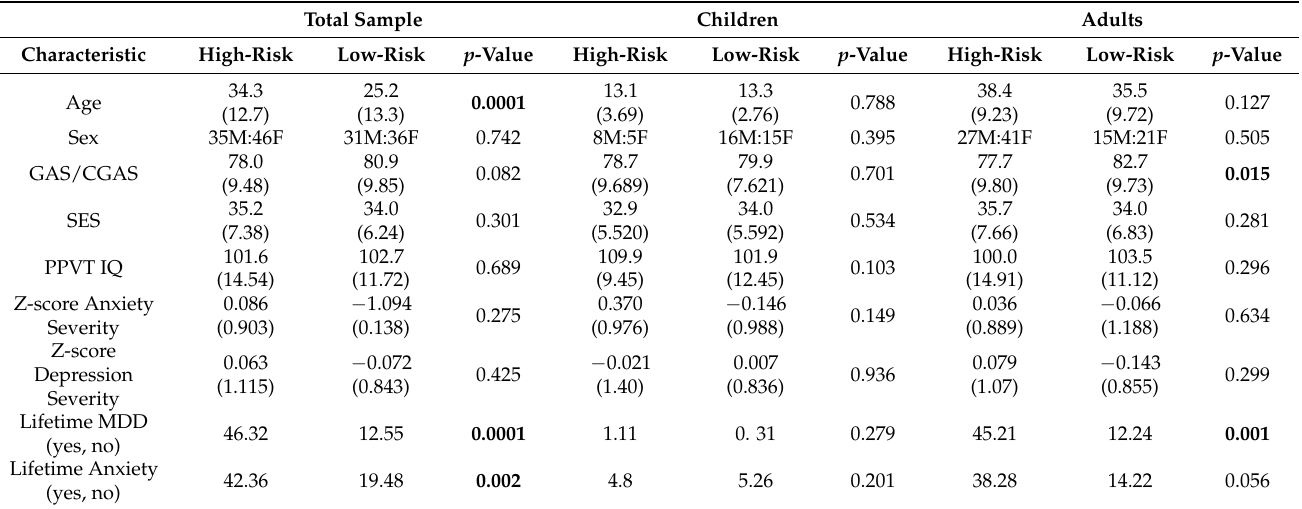
Table 1. Demographic and Clinical Characteristics of Study